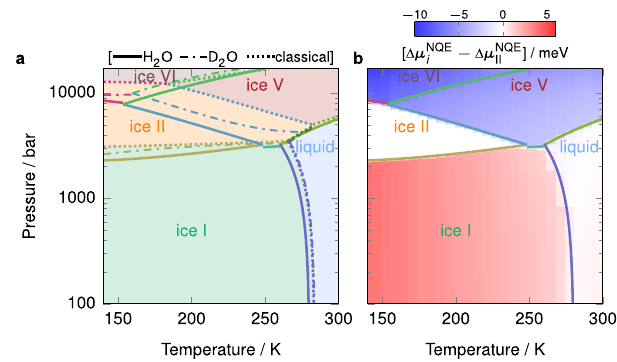
Fig. 4 Phase diagram dependence on NQEs. a Phase diagram excluding NQEs (dotted lines) alongside the full phase diagram (solid lines from Fig. 3c) and the phase diagram for D 2 O (dotted – dashed lines). b Heat map indicating the correction to the chemical potential of the stable phase i due to NQEs, relative to ice II, overlaid on the phase diagram from Fig.